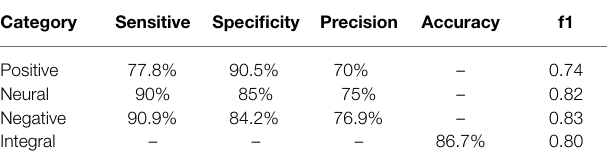
TABLE 6 | Support vector machine classification simulation training results. Category